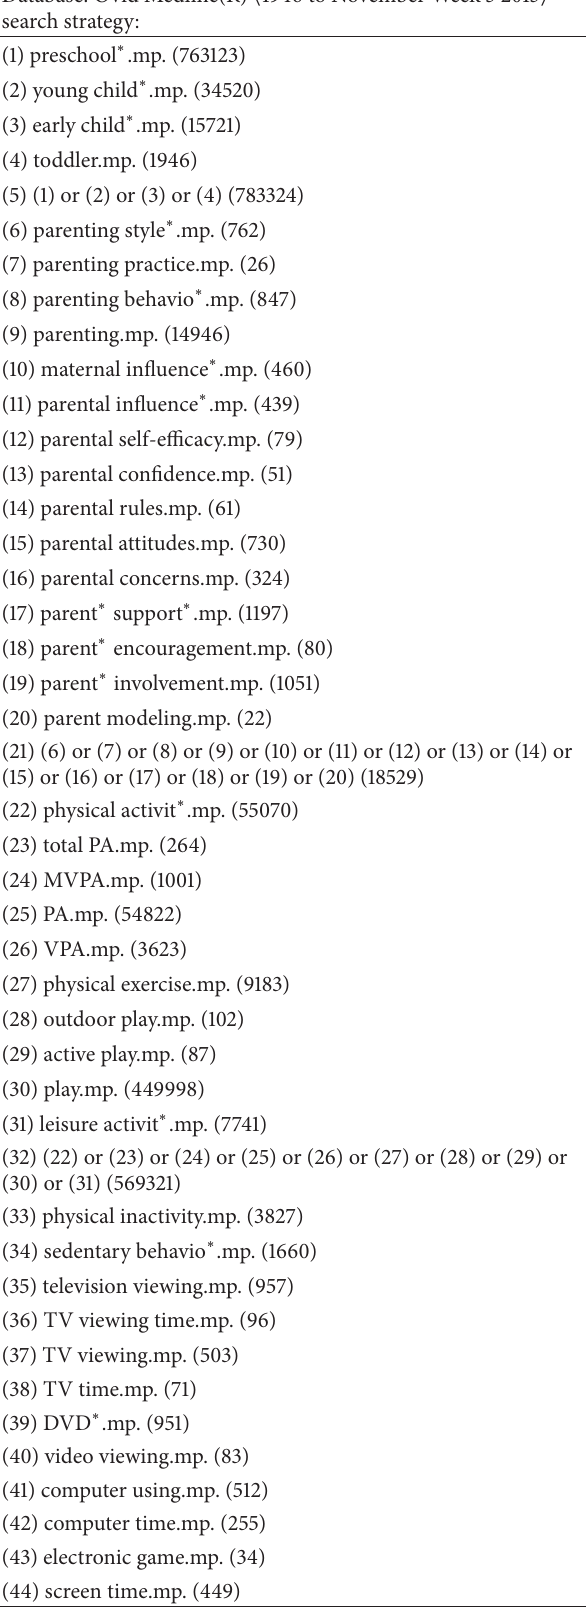
Table 1: The search strategy used for Medline